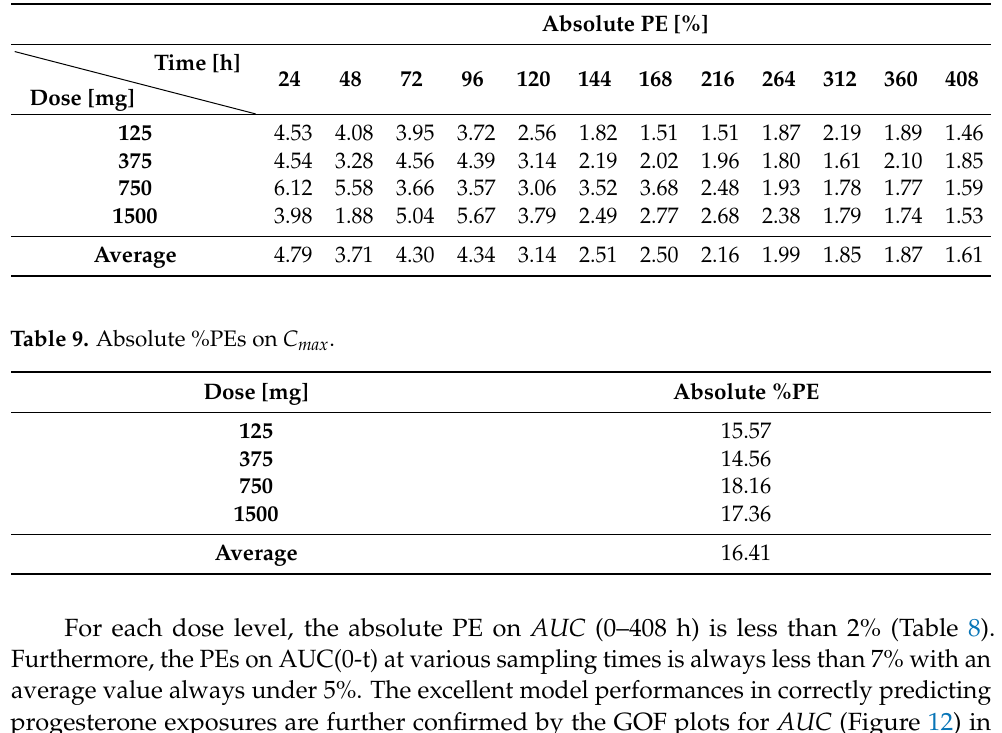
Table 8. Absolute prediction errors (PEs) on AUC[0-t].